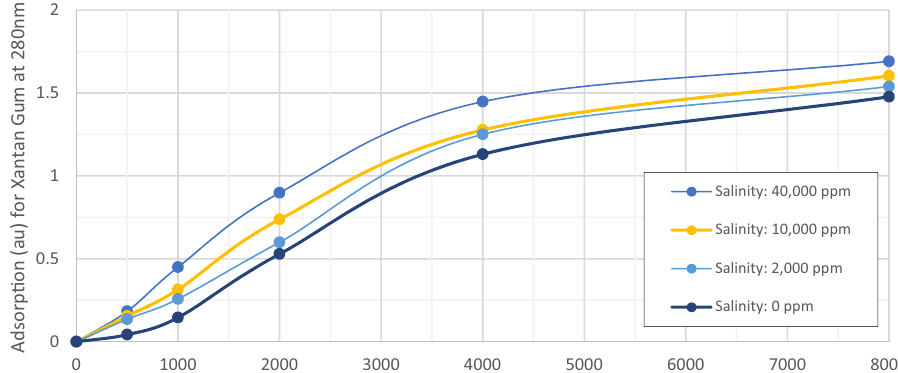
Fig. 4 Variation of the amount of xanthan gum adsorbed on 1 g of sand for different salinities